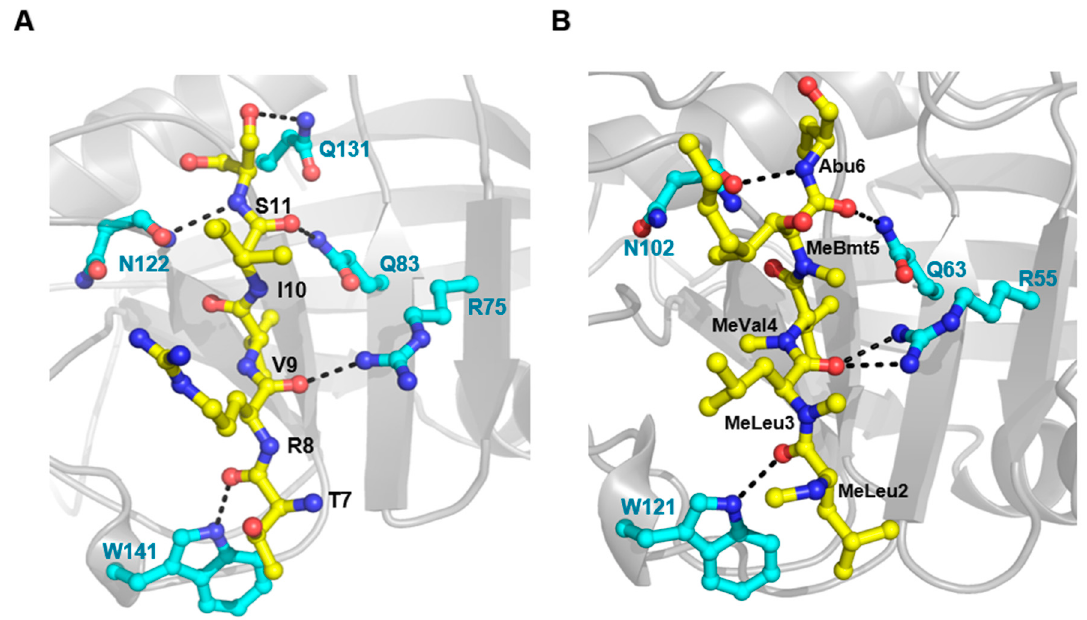
Figure 4. ( A ) The interactions between N-terminal segment and active site residues in Tv CyP2 contain 4 H-bonds shown by black dotted lines. ( B ) In comparison, 5 H-bonds are observed for the interactions between CsA and active site residues of h CyPA. Both Figures were generated by using PyMOL.